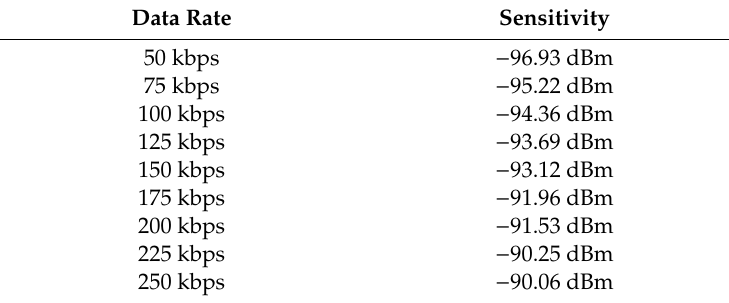
Figure 6. The relation between RSSI, data rate, and PER. Table 2. RSSI when the PER was 1% at different data rates.